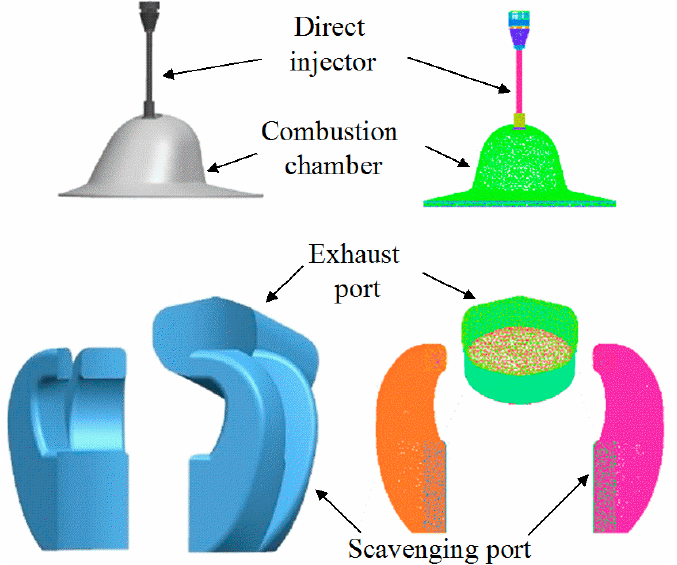
Figure 1. Three-dimensional engine model and meshing model of computational domains.